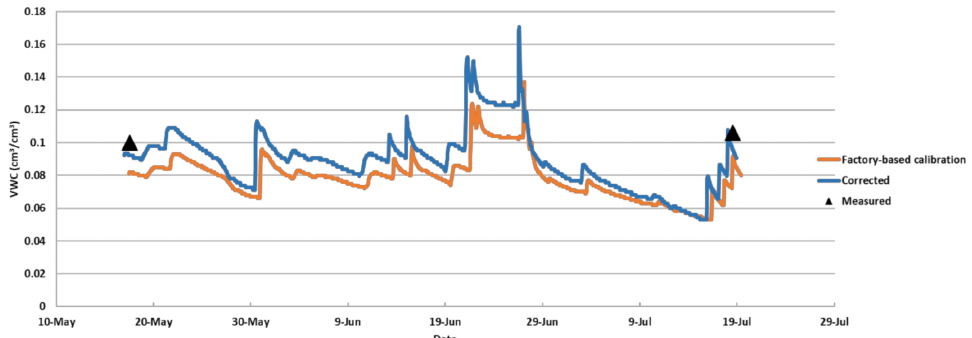
Figure 5. Comparison of factory-based calibration to corrected values for CS616 in sand.